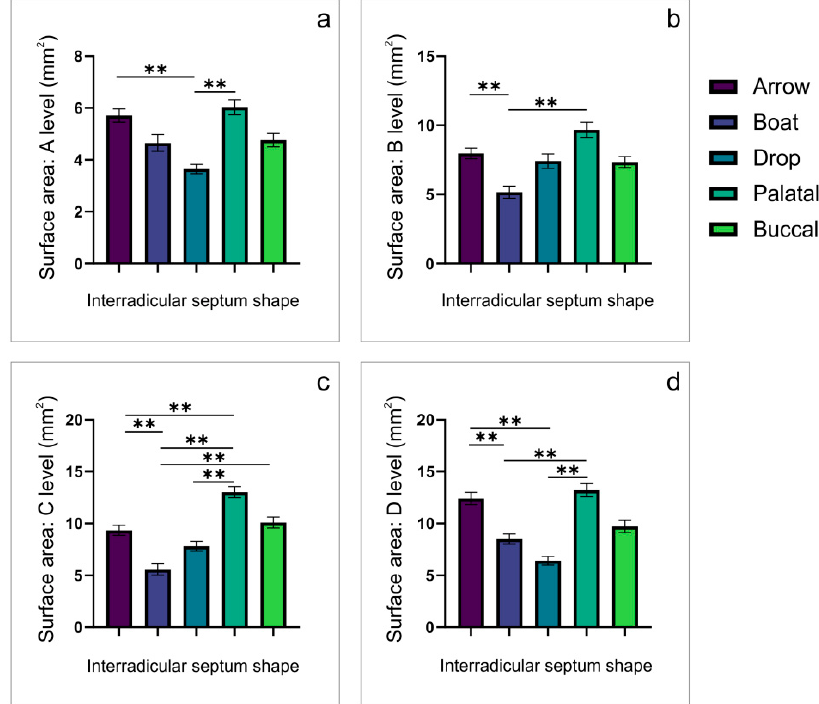
Figure 5. The observed differences in IRS surface area for the first maxillary molars obtained in the axial CBCT views. ( a )—at the A level; ( b )—at the B level; ( c )—at the C level; ( d )—at the D level. ** denotes a significant difference of p < 0.01.